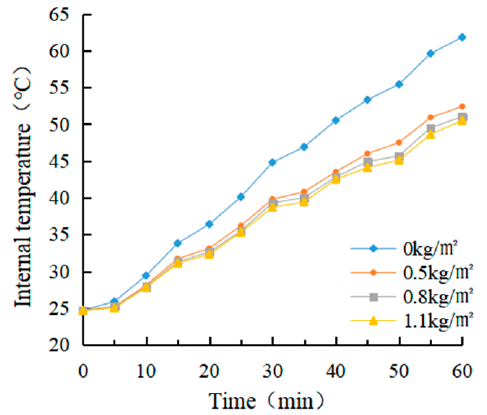
Figure 10. Internal temperature diagram.